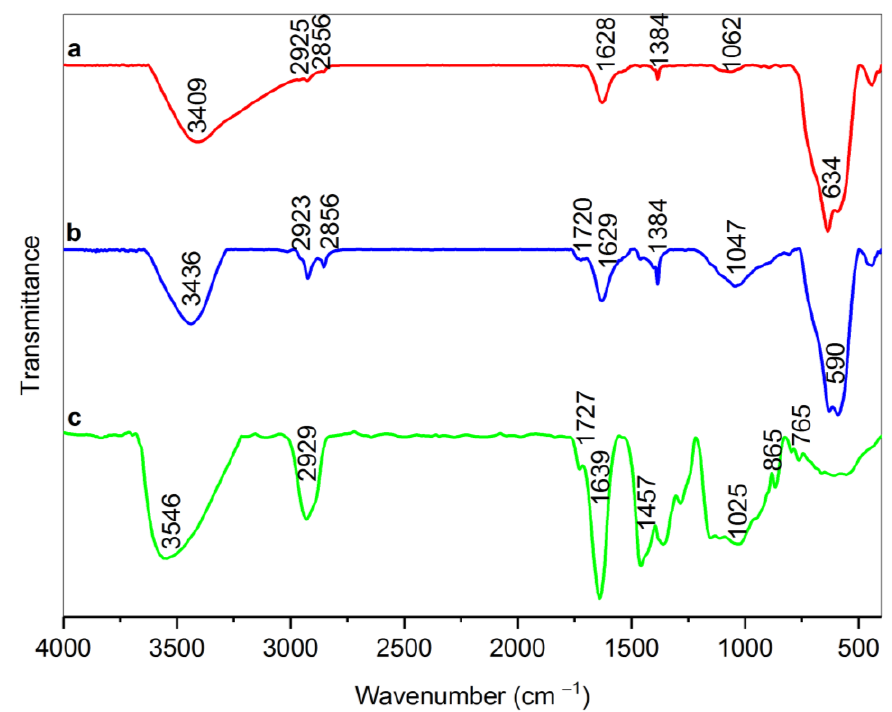
Figure 2. FT-IR spectra of RMNPs (a), Dext-RMNPs (b), and DextCHO (c).